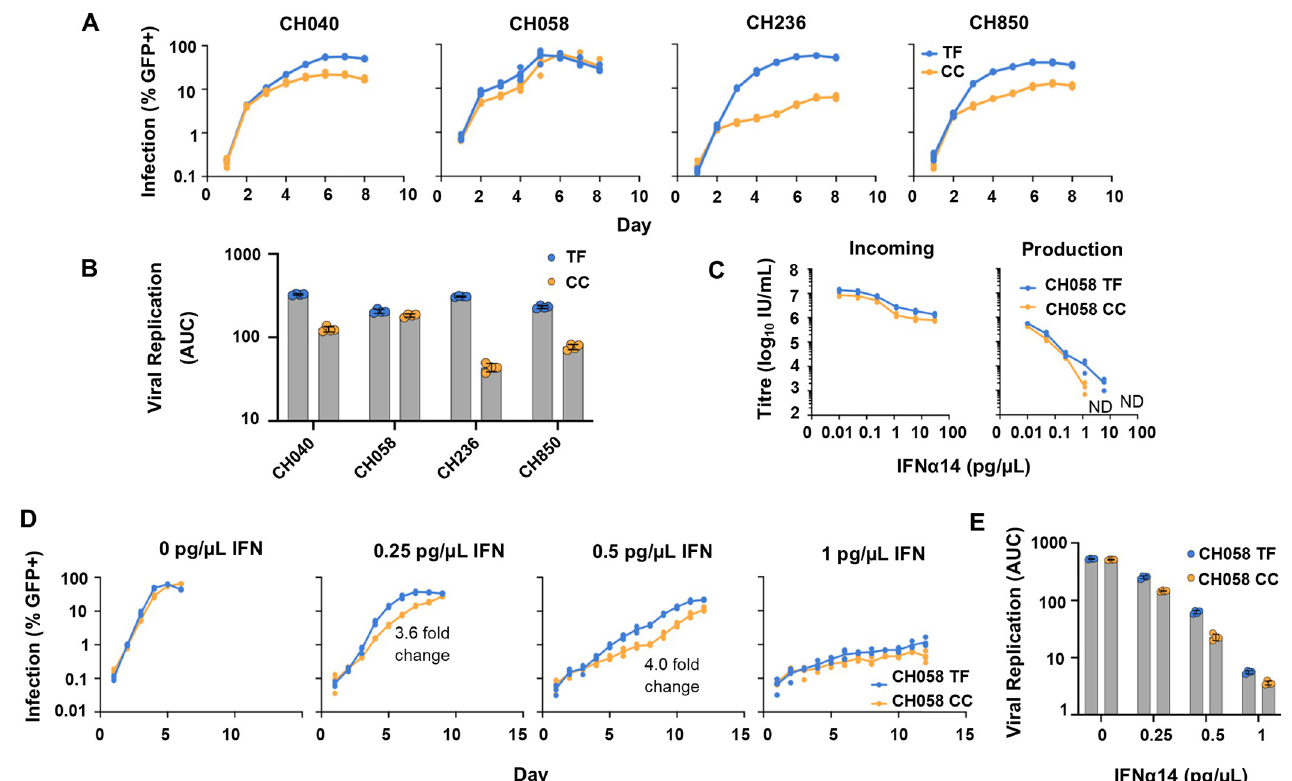
Fig 1. The CH058 TF virus is more resistant to IFN than its matched CC virus. (A-B) TMZR5 GFP-reporter cells were challenged with matched TF and CC VSV-G pseudotyped IMC pairs and sampled daily to monitor virus spread. GFP-positive cells were enumerated via flow cytometry. (C) To investigate the effect of IFN early in the viral life cycle (incoming infection), TMZR5 cells were pre-stimulated with different doses of IFN α 14 for 24 hours prior to infection with serially diluted CH058 TF and CC viruses. To limit replication to a single cycle, infected cells were treated with dextran sulphate 17–18 hours post infection. The percentage of GFP-positive cells was determined at 48 hours post-infection using flow cytometry. To investigate the effect of IFN late in the viral life cycle (production effect), TMZR5 cells were pre-treated with IFN α 14, and after 24 hours cells were challenged with CH058 TF and CC viruses at an MOI of 0.5 for 6 hours, before the inoculum was removed. At 46–48 hours post-infection, cell-free, filtered virus containing supernatants were titrated on TMZR5 cells. ND indicates not detected. (D-E) TMZR5s were treated with the indicated dose of IFN α 14 for 24 hours before being challenged with the CH058 TF and CC virus pair. Cells were sampled daily to monitor virus spread and GFP-positive cells were enumerated via flow cytometry. Annotated fold change values refer to the maximum difference in (%) infection out of the timepoints tested. Viral spreading replication experiments took place on two occasions and a typical result is